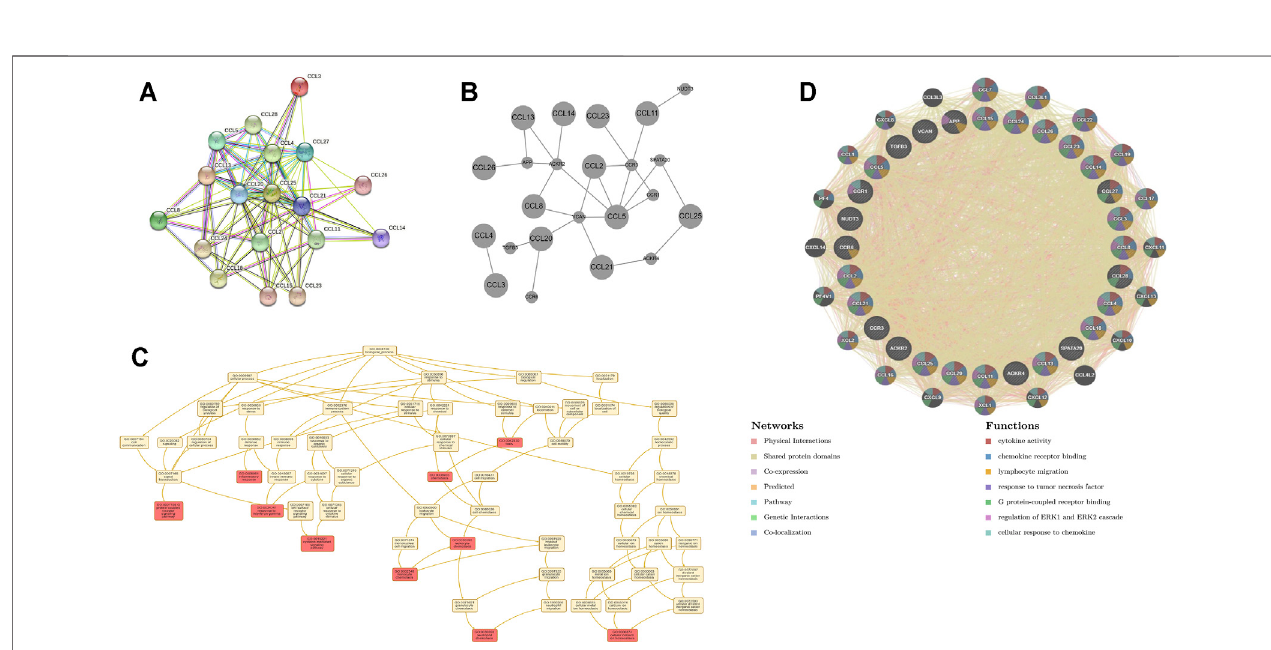
FIGURE4| PPInetwork,neighboringgenenetwork,interactionanalysesandfunctionalenrichmentofaberrantlyexpressedchemokinesCCLinLIHCpatients. (A) PPI network of aberrantly expressed chemokines CCL. (B) Gene – gene interaction network of aberrantly expressed chemokines CCL and their most frequently altered neighboring genes. (C) GO enrichment of chemokines CCL and their neighboring genes. (D) PPI network and functional enrichment of chemokines CCL and their neighboring genes.